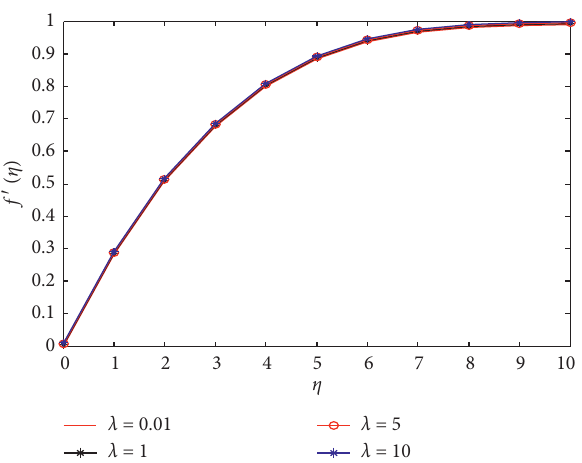
Figure 4: Velocity profiles for various values of the internal heat generation parameter ( λ ) when Pr � 0.72, Gr � 0.1, M � 0.1, Ra � 0.1, and Bi � 0.1.